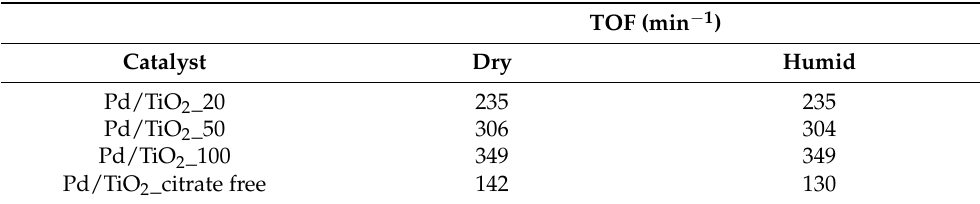
Table 3. TOF values of different Pd/TiO 2 _x (x = 20, 50, 100) and Pd/TiO 2 _ citrate free catalysts under dry and humid